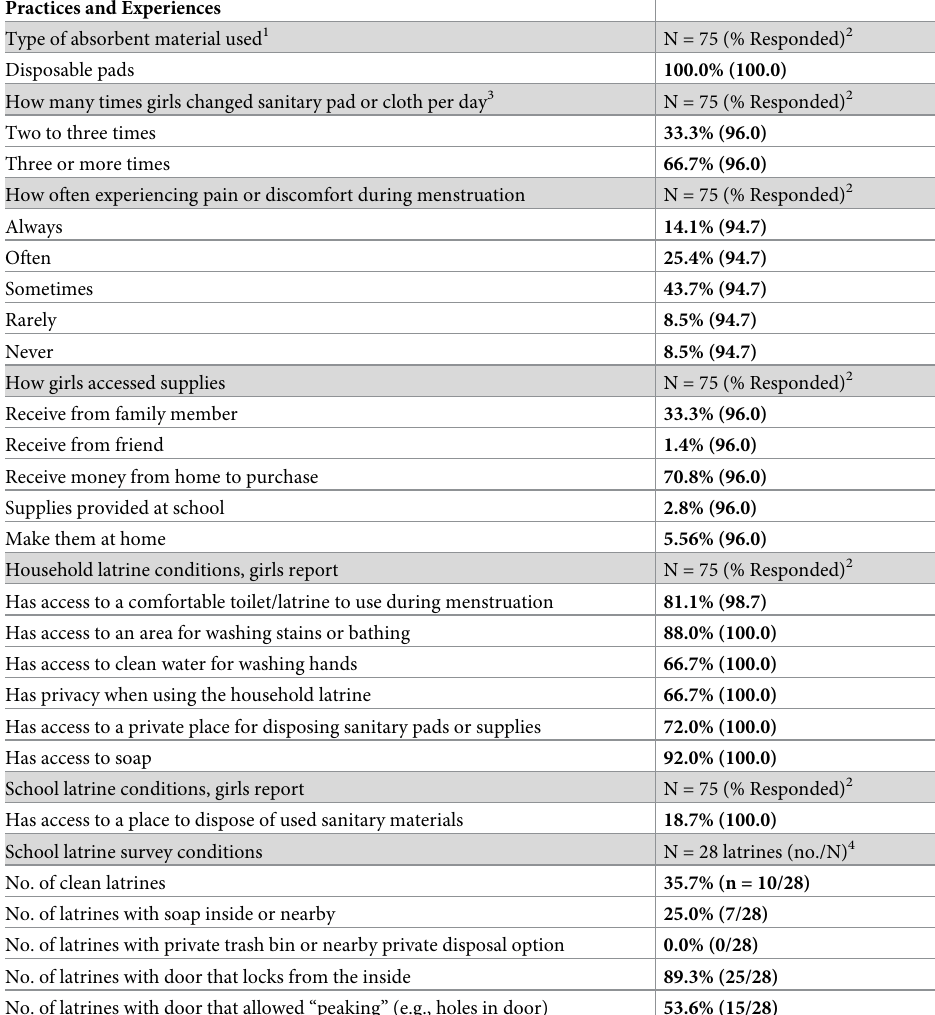
Table 5. Managerial practices and experiences during